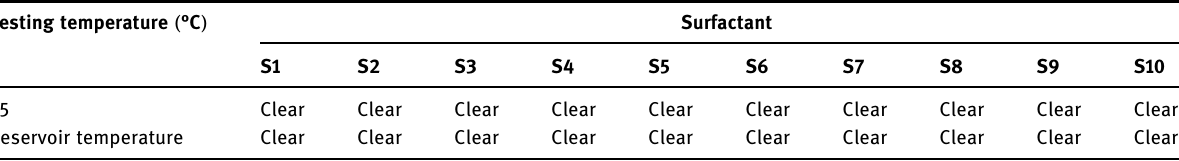
Table 3: Summary of solubility and compatibility results at 1.0 wt% concentration after 7 days Testing temperature ( °C